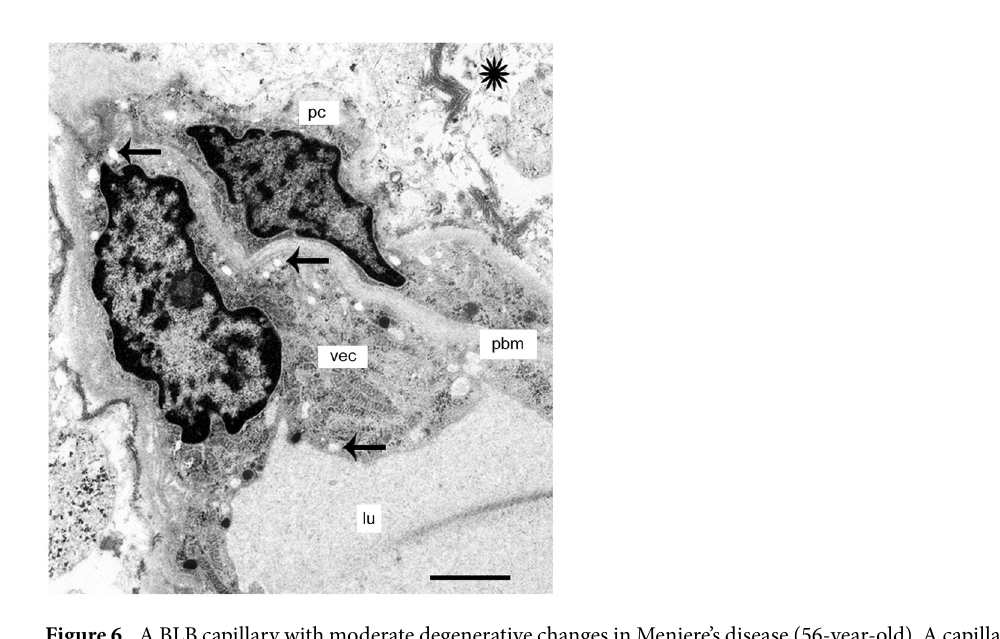
Figure 6. A BLB capillary with moderate degenerative changes in Meniere’s disease (56-year-old). A capillary shows moderate vacuolization of the vascular endothelial cell (vec) and pericytes (pc) and mild edema in the stroma (arrows). The perivascular basement membrane (pbm) is thickened. The stroma shows signs of edema (asterisk). Bar = 2 μ